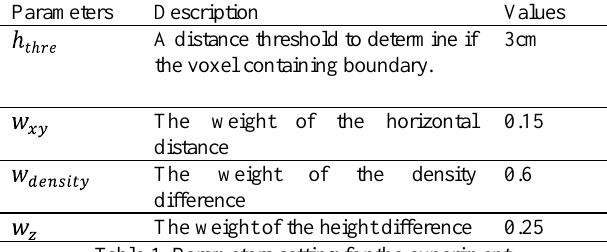
Table 1. Parameters setting for the